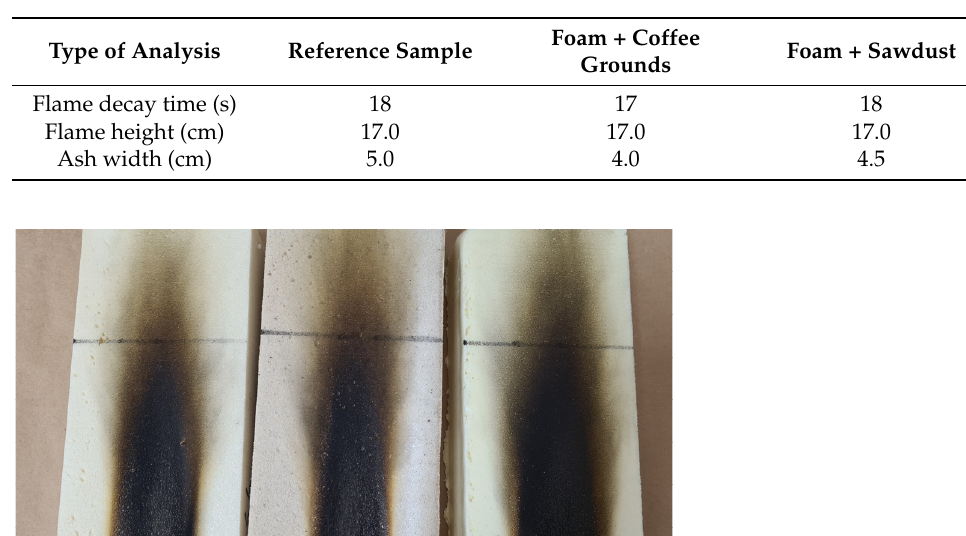
Table 4. Flammability test results.